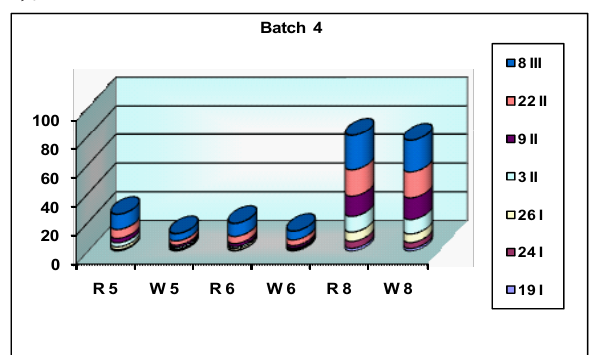
Fig. 8. The final average length of the branches, in cm, for batch